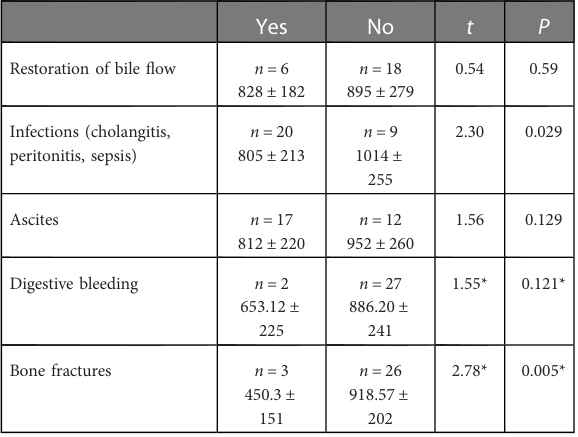
TABLE 1 Comparison of PMI regarding pre-liver transplantation variables.